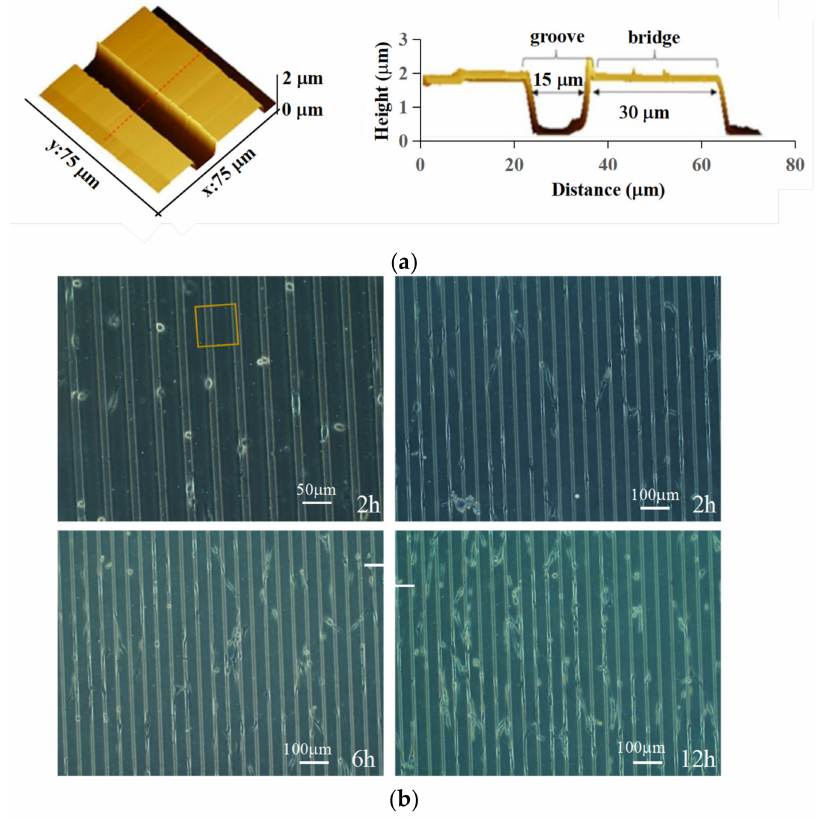
Figure 1. ( a ) AFM morphology of patterned substrate; ( b ) cells spread on the flexible culture dish with micro-patterns for 2 h, 4 h, 6 h and 12